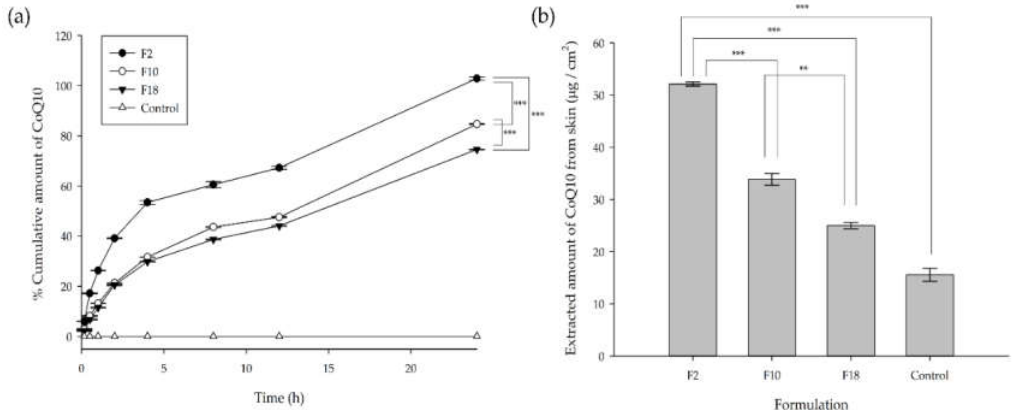
Table 3. Physicochemical properties of selected formulations (Mean ± SD, n =